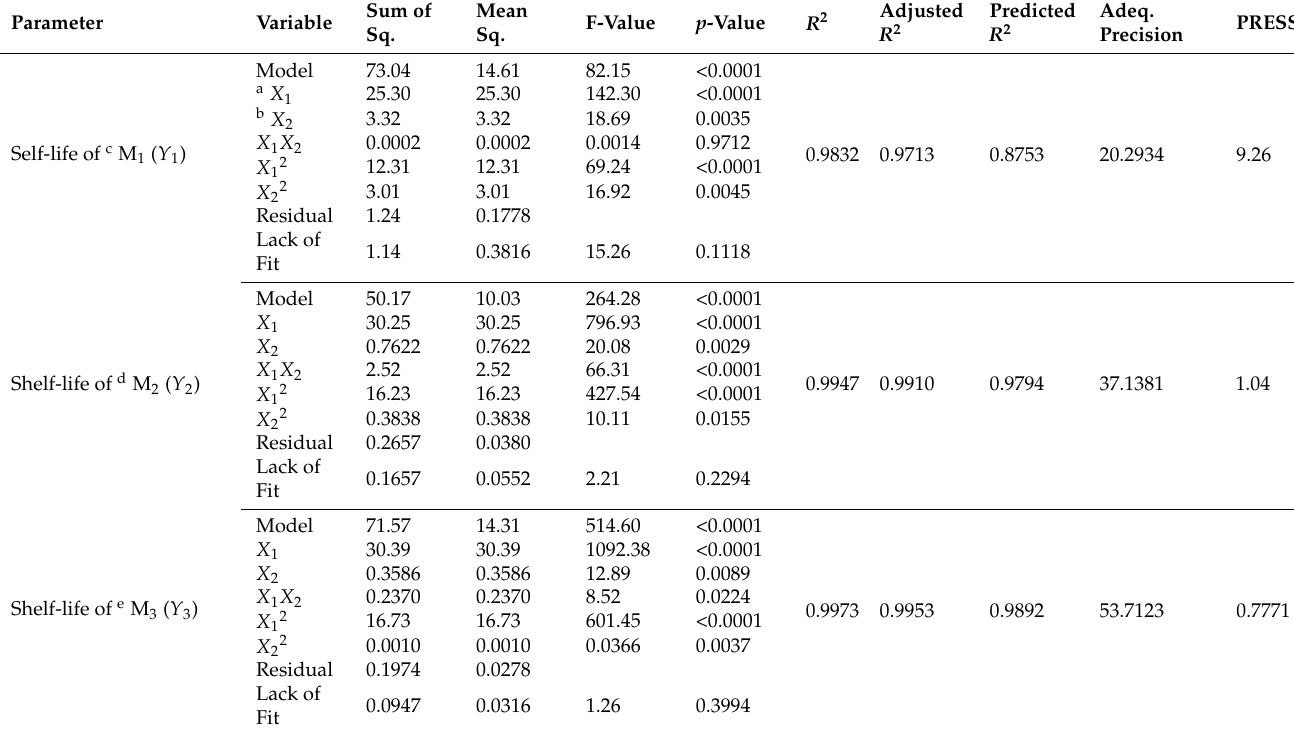
Table 3. Model variables and ANOVA results for shelf-life of mushrooms (days) stored at ambient